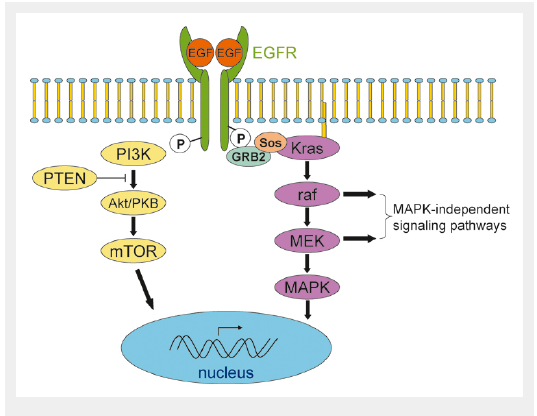
Principal signalling pathways activated by the EGF receptor. Activated EGF receptors dimerise and start signalling through the PI3K-AKT/PKB-mTOR and the Kras-Braf-MEK pathway. Activation of Kras and Braf triggers not only MAPK signalling but also MAPK- independent signal